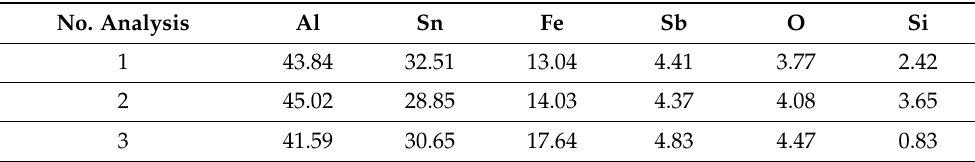
Table 10. EDX analysis of selected zones from Figure 4f of the wear surface of hybrid material at a load of 60 N, mass norm.,